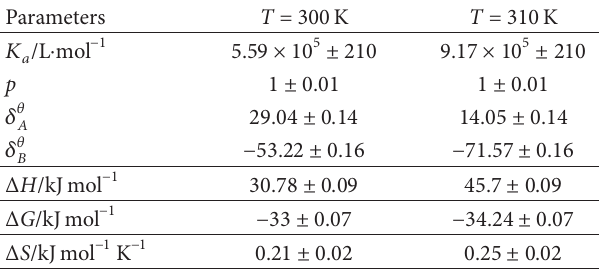
interactions. e big association equilibrium constant values show that there is strong and HSA. e entropy driven of the interaction between Yb interaction indicates that minimizing the number of hydrophobic 3+ side chains exposed to water is the principal driving force behind the folding process. e large and